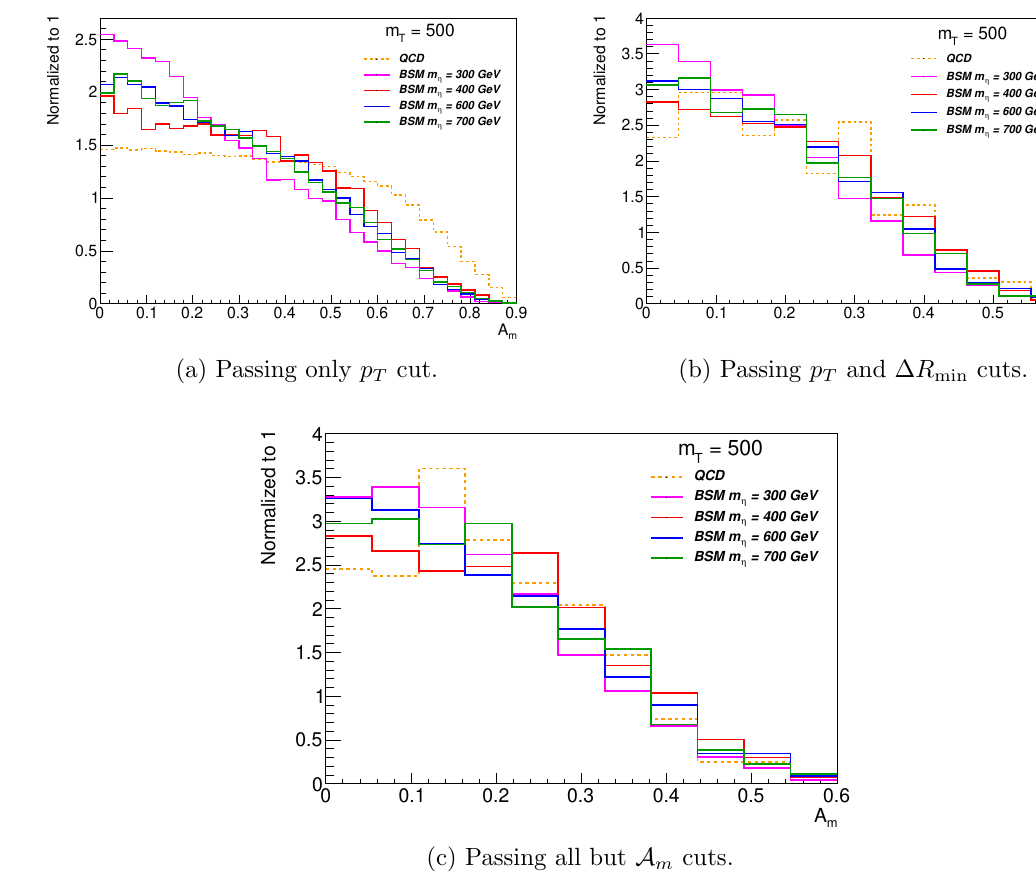
Figure 6. The A m spectrum passing the various selection criteria as highlighted in the ATLAS search [50] for m T = 500 GeV. The distributions of the (a) are for events passing only the p T requirement, the (b) satis(cid:12)es both p T and (cid:1) R min requirements, and the (c) have all except A m cuts